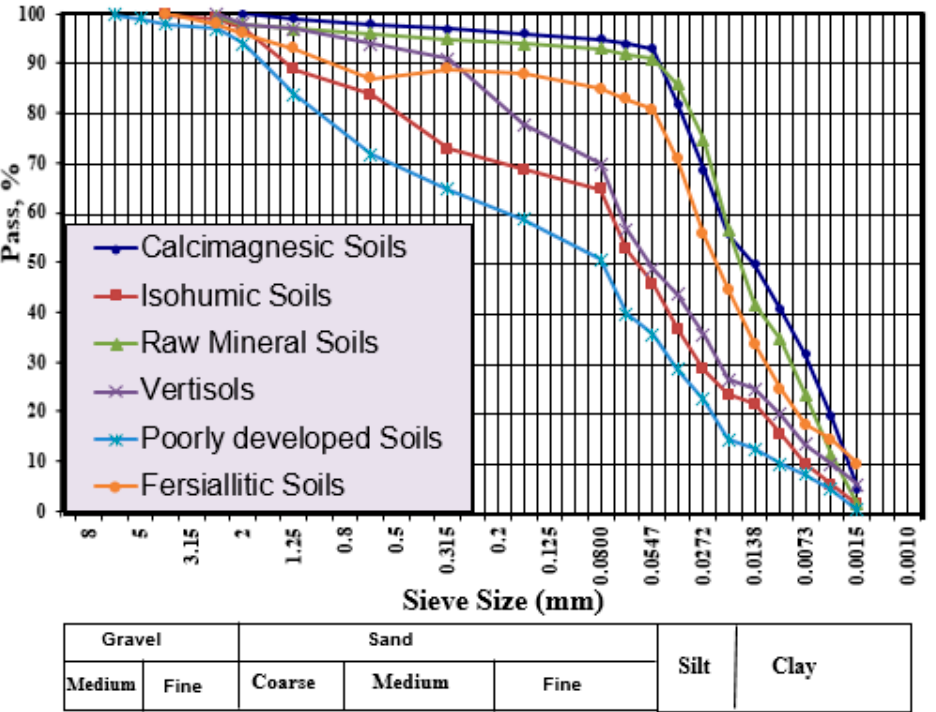
Figure 3. Particle Size Distribution Curve.